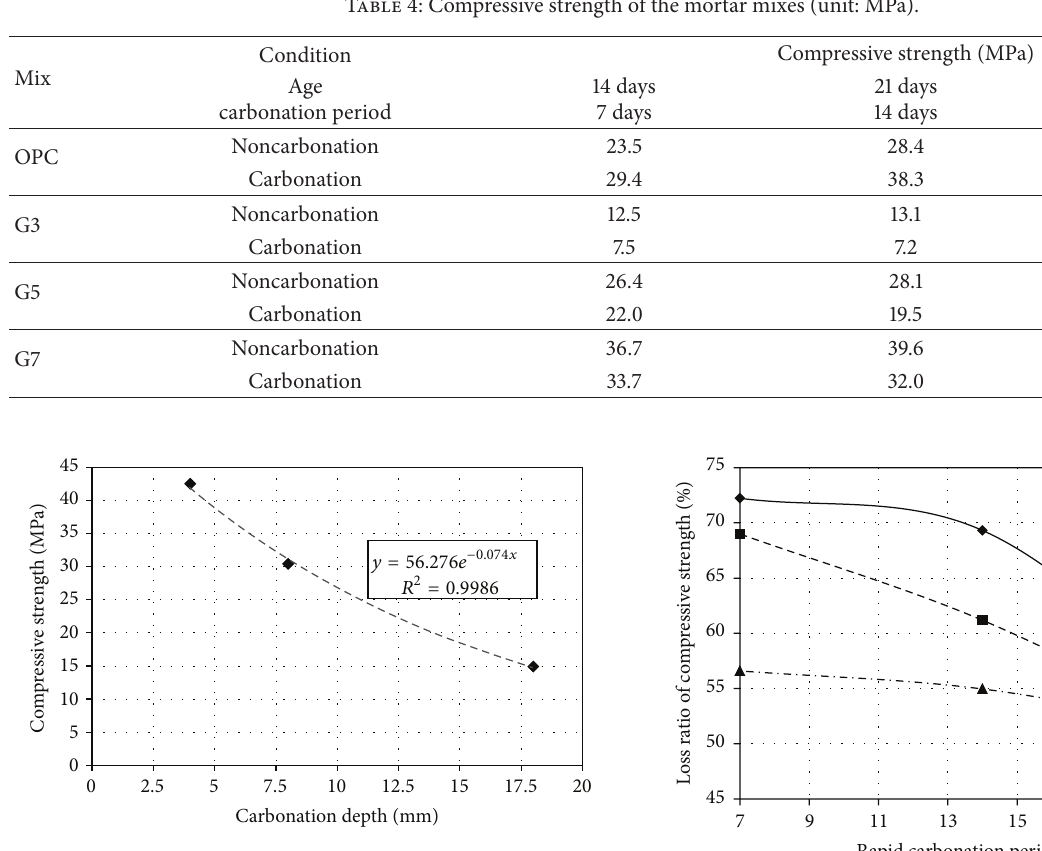
Figure 4: Relationship between the compressive strength and the carbonation depth with rapid carbonation for seven days in AAS mortar.